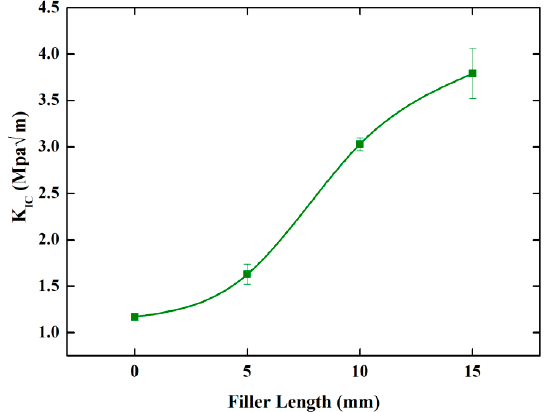
Figure 16. Filler length effect on the fracture toughness of bamboo fiber composites.